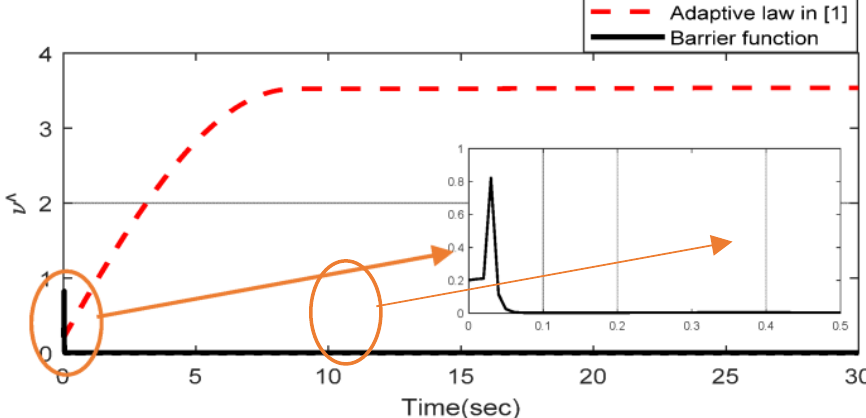
Figure 4. Time responses of the non-singular terminal sliding surface.